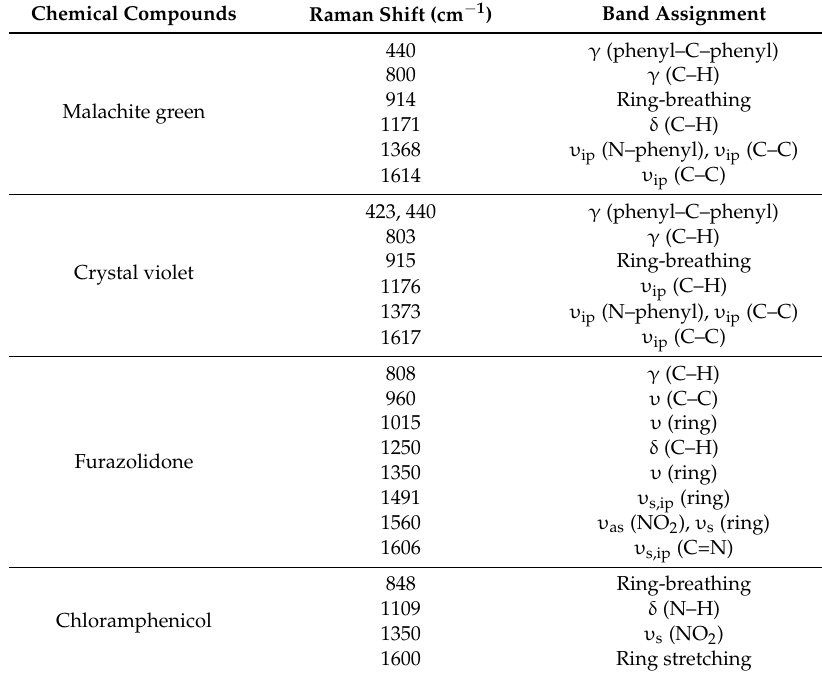
Table 2. Assignments of vibrational bands of malachite green, crystal violet, furazolidone, and chloramphenicol [32,34,36,37]. Chemical